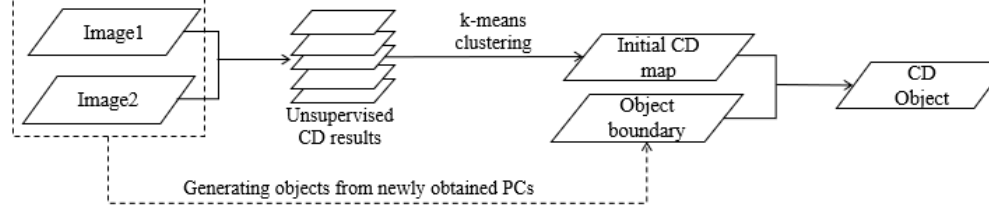
Figure 2. Generation of CD objects. The pixels were classified as belonging to the same class in more than four methods among the five unsupervised CD methods and were selected to constitute the initial CD map, which was reconstructed in object units with threshold percentages, i.e., specific percentages of pixels in an object; in this study, 50%, 60%, and 70% were used to generate CD objects.